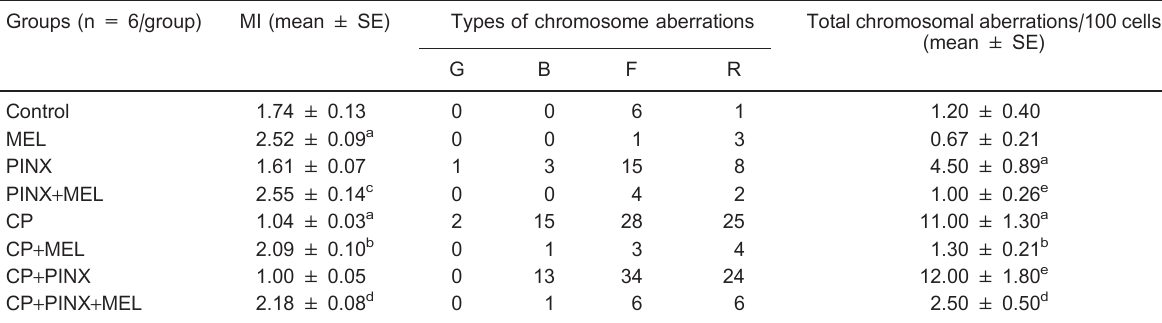
Table 2. Effect of melatonin on the mitotic index (MI) and frequency of cells with chromosome aberrations induced by cyclophosphamide (CP, 20 mg/kg). Groups (n = 6/group)